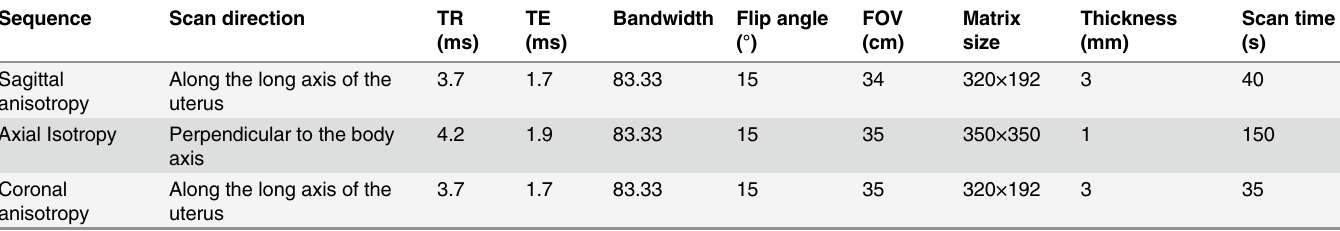
Along the long axis of the uterus Note: Scan slices varied according to patient ’ s body size, therefore, the scan time for each patient may have also varied. Sagittal and coronal scans covered the entire pelvic cavity and the axial scan covered the entire uterus and